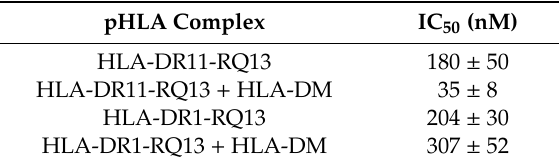
Table 3. HLA-DR a ffi nity for the RQ13